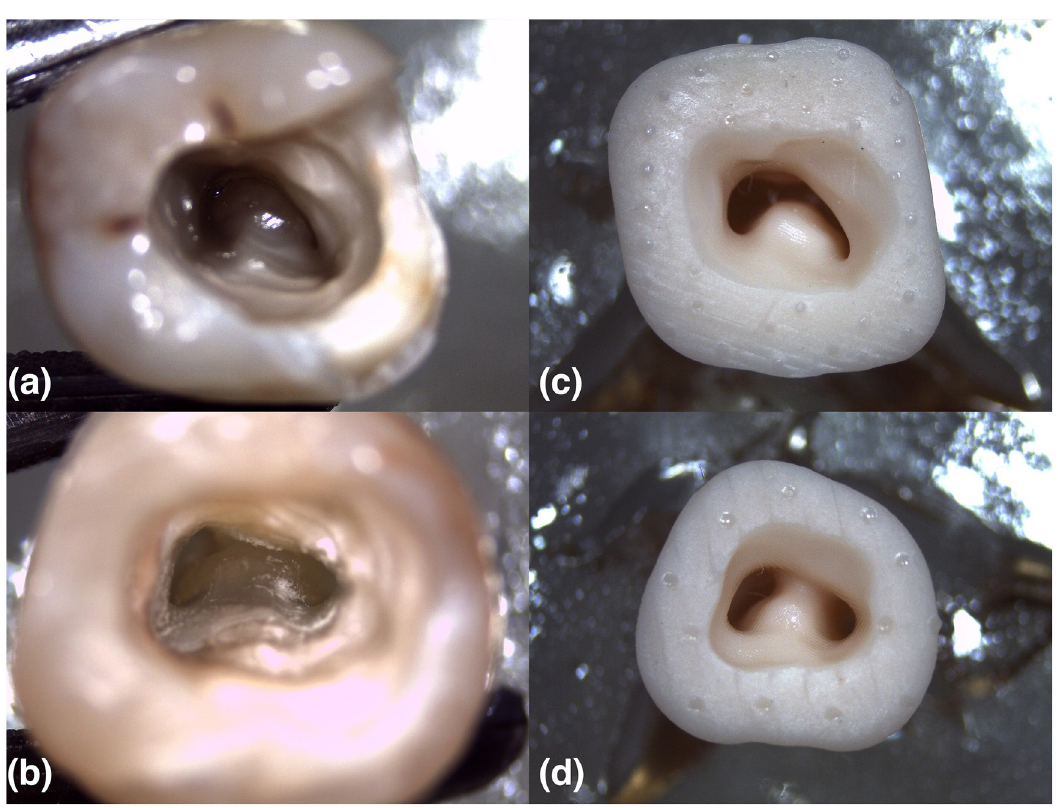
Fig 1. Coronal view of C-types: (A)C1-type mandibular molar, (B)C2-type mandibular molar, (C)C1-type 3D printed resin replica, (D)C2-type 3D printed resin